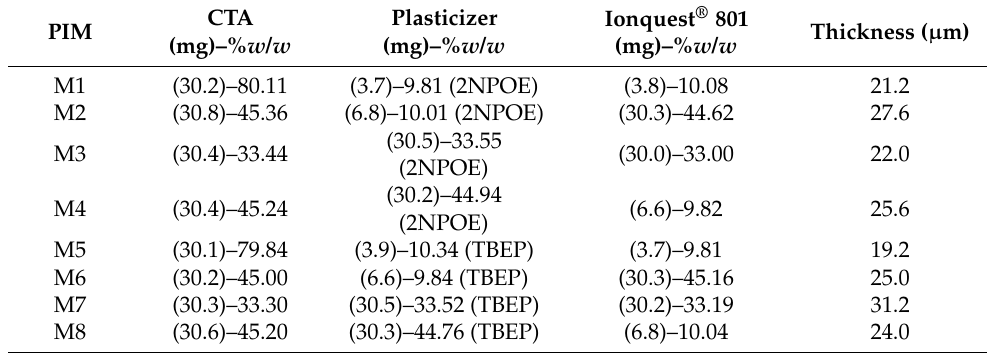
Table 7. PIM compositions for EIS characterization.